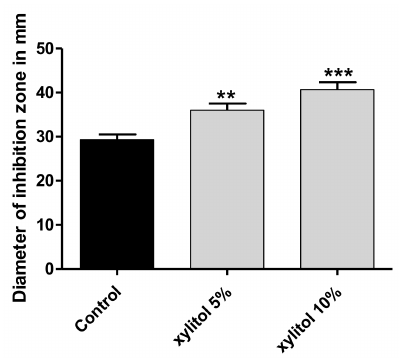
Figure 5. Augmentation of sensitivity to oxidative stress by xylitol. Aliquots of 100 µ L of overnight culture of S. marcescens were spread on the surface of TSA plates with and without xylitol and 10 µ L of 3% hydrogen peroxide were added to a filter-paper disk on the plates. The plates were incubated and the inhibition zones were measured. The test was performed in triplicate. Xylitol significantly increased the inhibition zones and the sensitivity to oxidative stress. The data shown are the means ± standard errors. One-way ANOVA test followed by Dunnett’s Multiple Comparison test was used for statistical analysis. **: p ≤ 0.01 and ***: p ≤